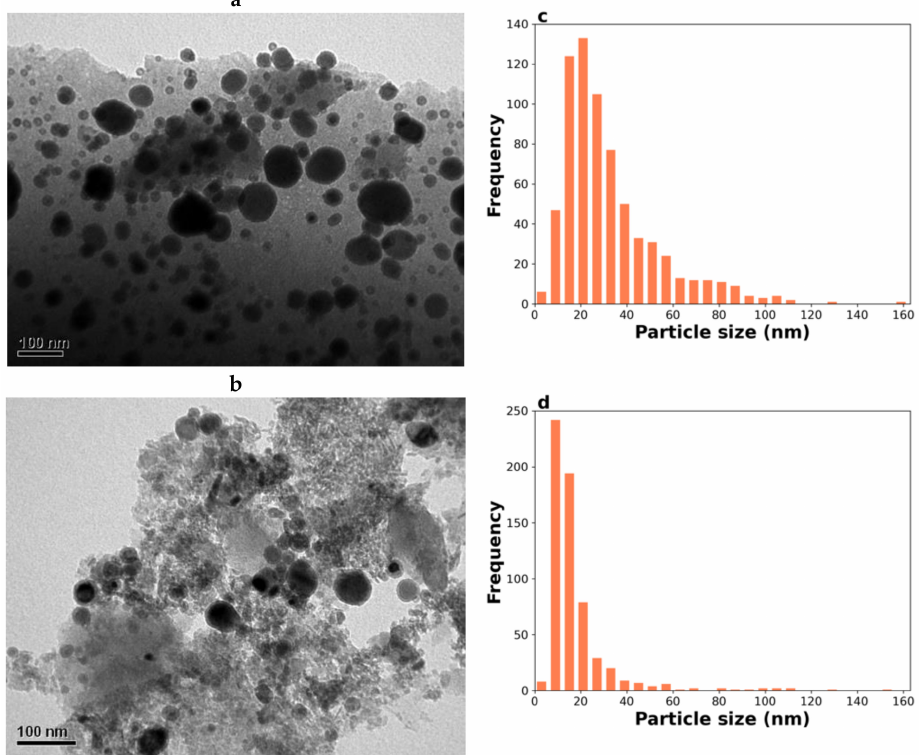
Figure 2. Transmission electron microscopy image and particle size distribution (PZD) of the catalysts: ( a ) Fe/CAG image, ( b ) Fe/CAG-ps image, ( c ) Fe/CAG PZD, and ( d ) Fe/CAG-ps